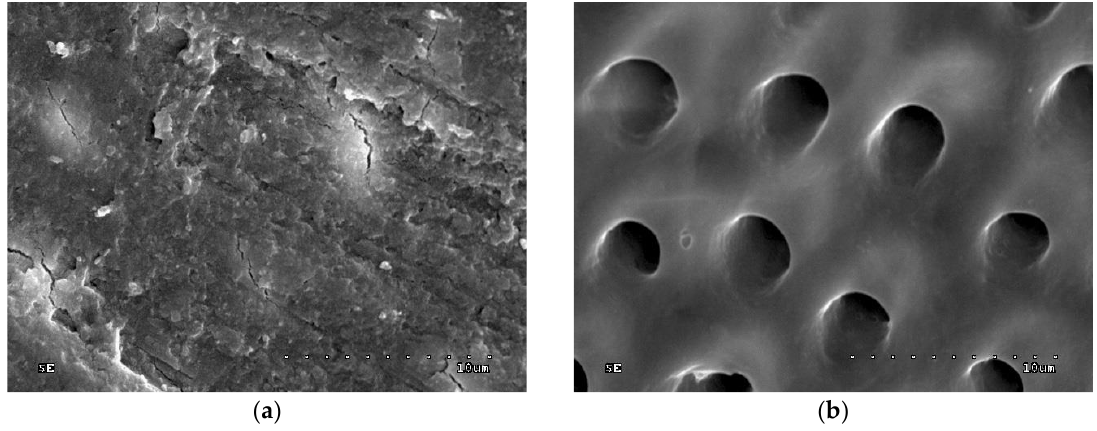
Figure 1. Scanning electron microscopy (SEM) image of dentine surface: ( a ) Prepared with bur, unetched–control group (group 1), 1000×; ( b ) etched with 36% orthophosphoric acid—group 2, 5000×.